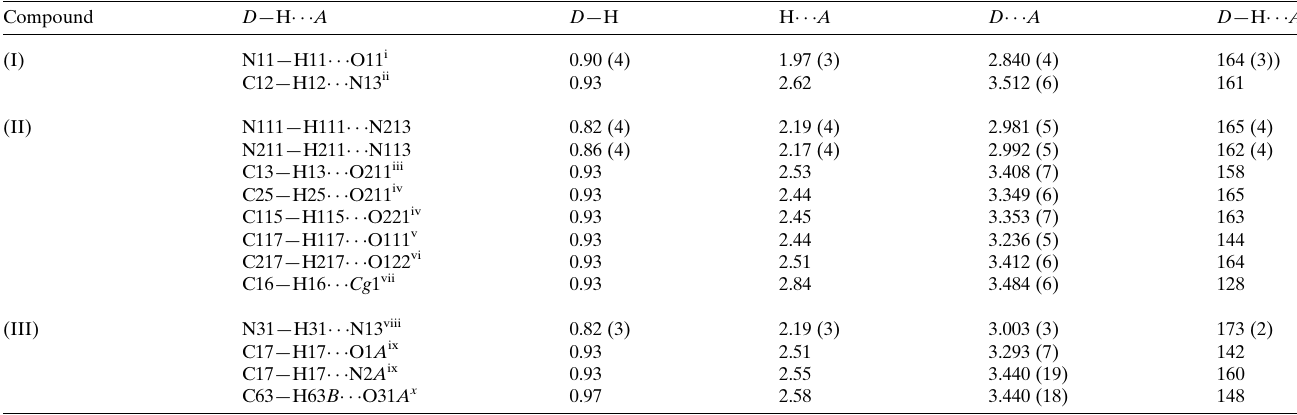
Table 1 Hydrogen bonds and short intermolecular contacts(A˚ , (cid:2) ). Cg 1 represents the centroid of the ring C13 A /C17 A /C117/C116/C115/C114 Compound